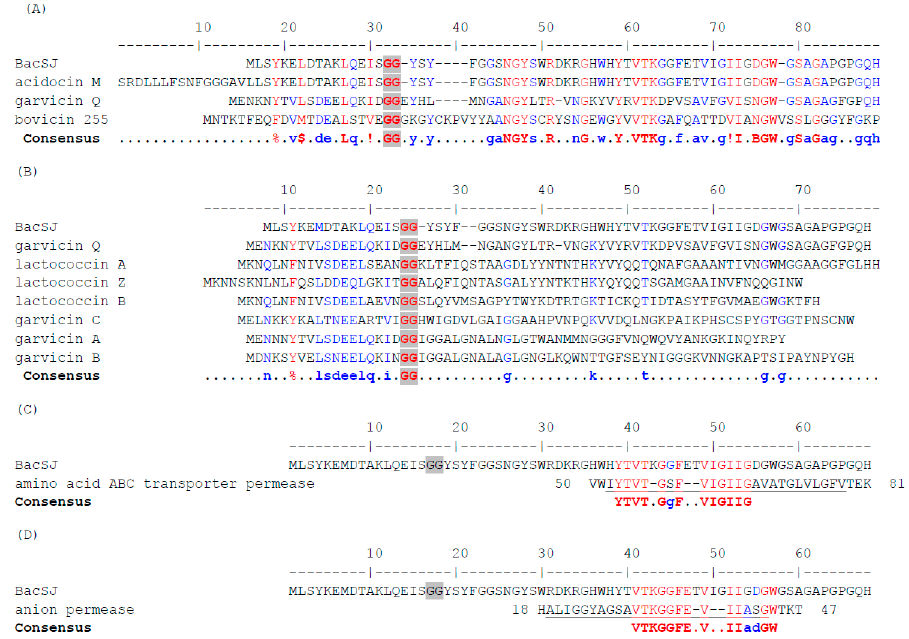
Figure 1. Alignment of the amino acid sequences of BacSJ prepeptide with its homologs ( A ), with bacteriocins that use mannose-specific phosphotransferase system (Man-PTS) as a receptor ( B ), with Branched Chain Amino Acid (BCAA) ATP-Binding Cassette (ABC) transporter permease ( C ), and with anion permease ( D ). Fully conserved residues are in red, partially conserved ones in blue. Consensus symbols are: !—I or V; $—L or M, %—F or Y, B—D or N. Double glycine (GG) motifs are highlighted by grey background. Transmembrane regions are underlined. NCBI RefSeq or GenBank